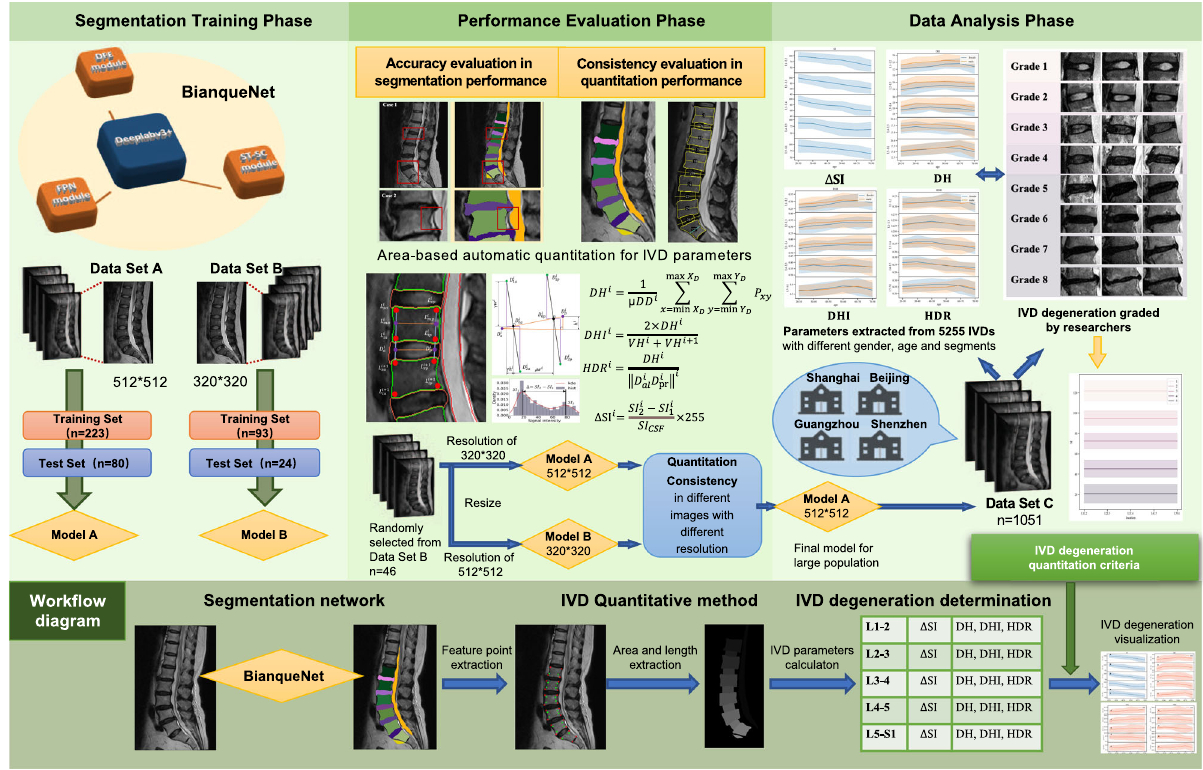
Fig. 1 A fl owchart of the study process from training and testing phase to data analysis phase with BianqueNet. Mid-sagittal T2W lumbar MR images exported into two different resolutions (512*512, 320*320) are used to train and test two models (Model A, Model B). After segmentation accuracy evaluation, IVD parameters are quanti fi ed based on IVD-related area. As Model A shows good performance on quantitation consistency for MR images with various resolutions, it is used to establish baseline characteristic with different IVD degeneration among 5255 IVDs. Work fl ow diagram at the bottom presents the segmentation network, IVD quantitation method, and IVD degeneration